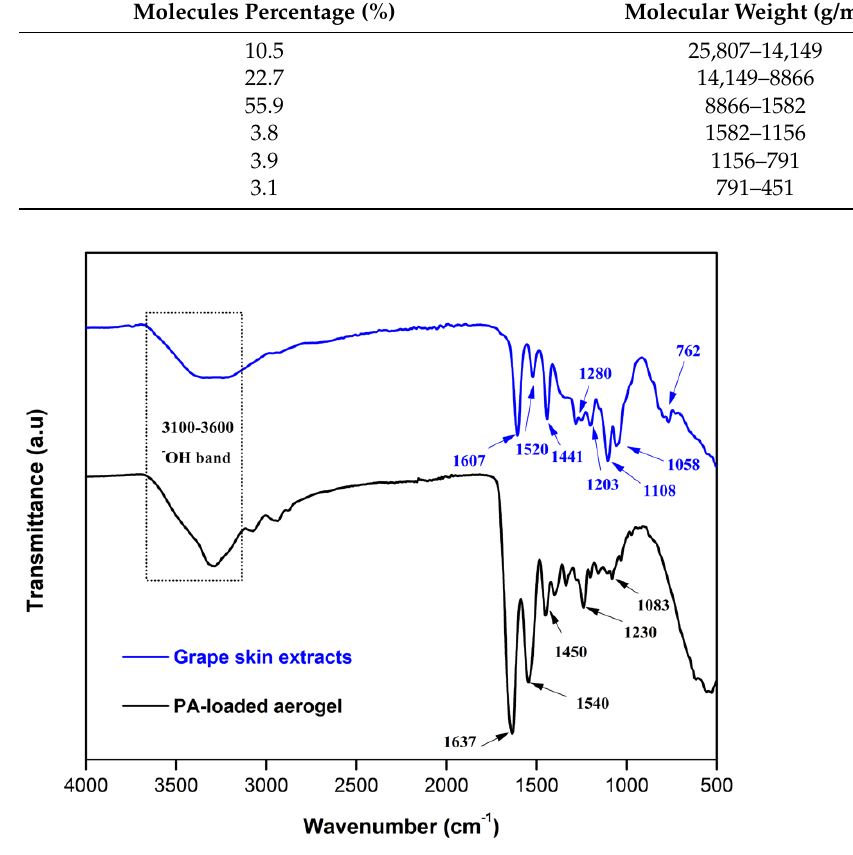
Figure 2. ATR-FTIR spectra of grape skin extract and PA-loaded aerogel showing their main func- tional groups.